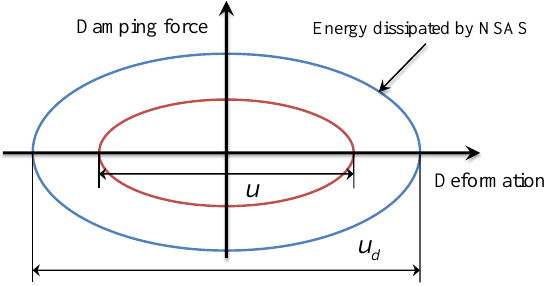
Figure 3. Illustration of energy-dissipation-enhancement effect of NSAS.